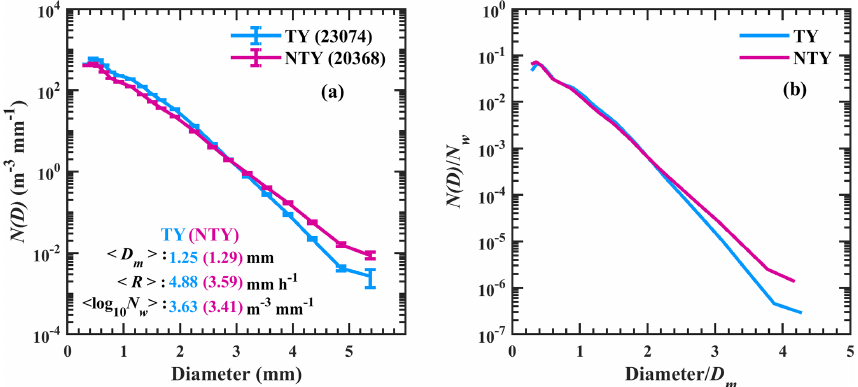
Figure 3. (a) Distributions of mean concentration ( N(D) in mm − 1 m − 3 ) with raindrop diameter for typhoon (TY) and non-typhoon (NTY) rainfall and their (b) normalized